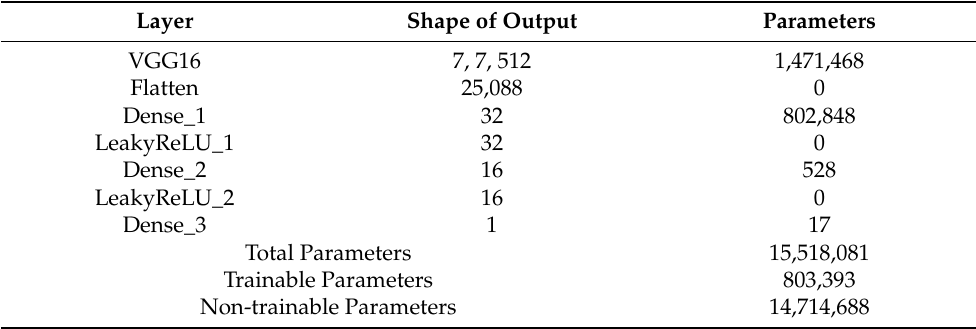
Table 4. Parameters of Proposed Model.